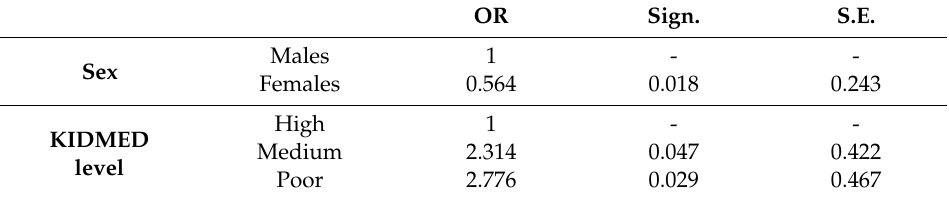
Table 5. Multivariate logistic regression model. Outcome variable: ‘overweight or obese’ vs. ‘normal weight or underweight’. Sign. = significance; S.E. = standard